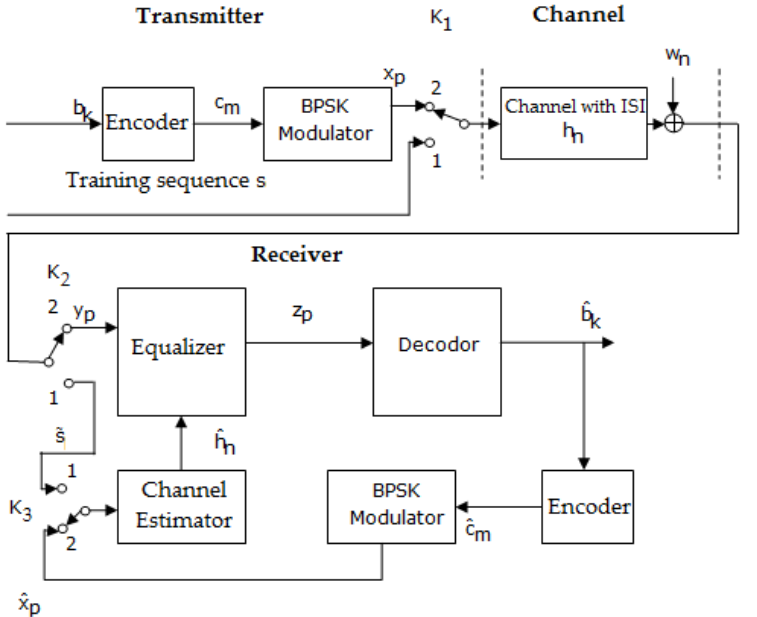
Figure 10. Block diagram of a transmission–reception system that performs the iterative estimation and the equalization of the channel at the reception, in the case of applying LDPC codes and polar codes [46].